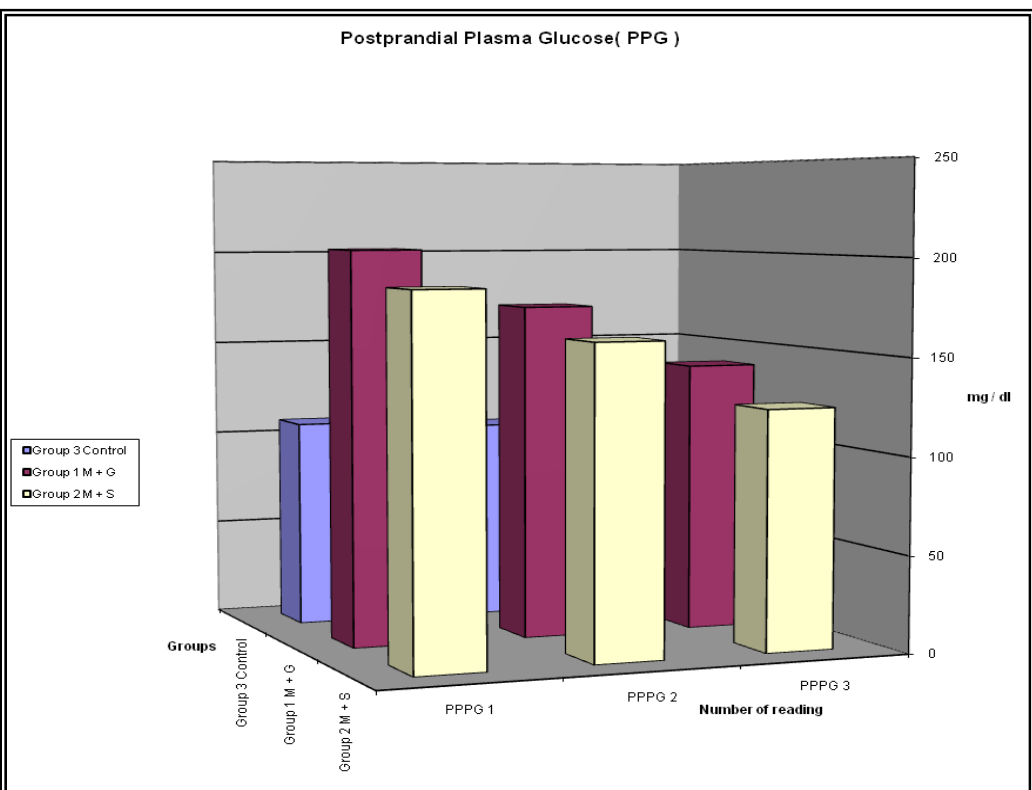
Figure 2 : Histogram showing effect of treatment with metformin 500 mg 3 times daily + glibenclamide 5 mg twice daily (group 1) versus group 2 metformin 500 mg 3 times daily + sitagliptin 100 mg once daily (group 2) on PPG in patients with T2DM and group 3 control normal healthy individuals (group 3) after 1,3 and 6 months of treatment.( n = 34 individuals for each group